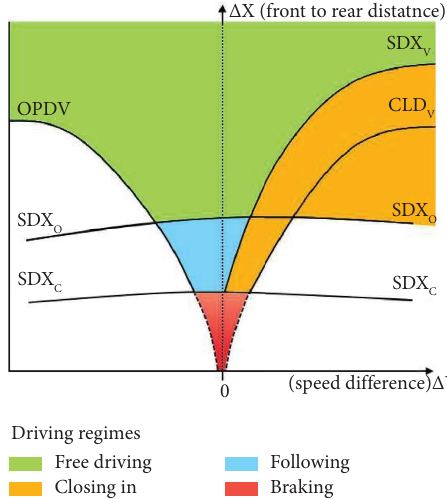
Figure 1: Wiedemann 99 car-following model driving regimes and thresholds adapted from PTV Vissim